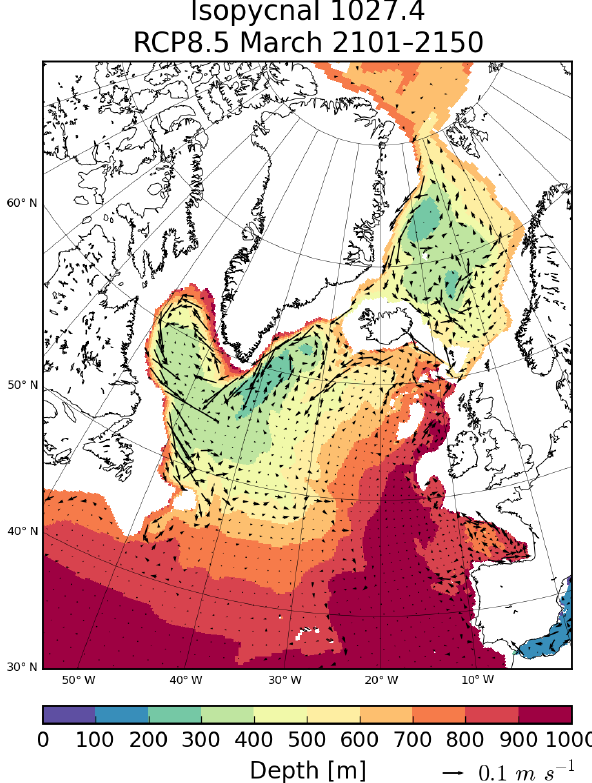
Figure A3. Depth of the 1027.4 isopycnal in March under RCP8.5 conditions (2101–2150, E0), with the density of 1027.4kgm − 3 be- ing representative of intermediate depths (500–1000m) in the NE Atlantic sector (45–62 ◦ N, 15–28 ◦ W). Vectors illustrate the corre- sponding flow field at the